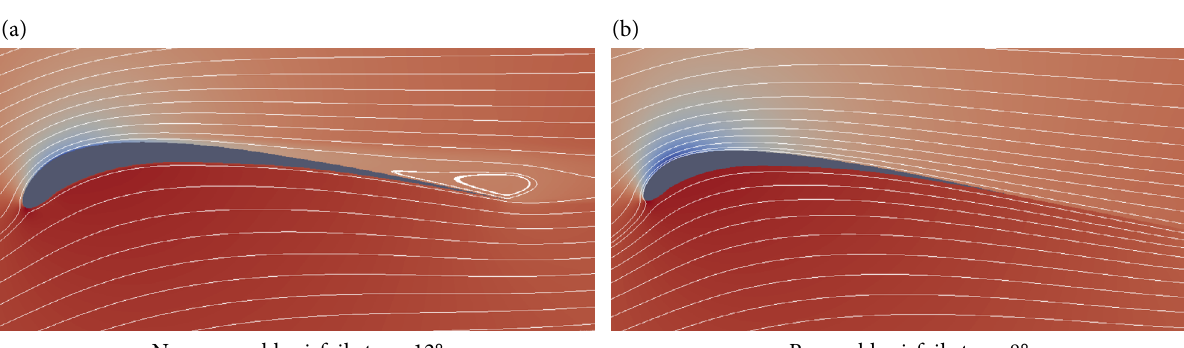
Figure 13. Exhibition of streamlines at stall angle of attack for permeable and